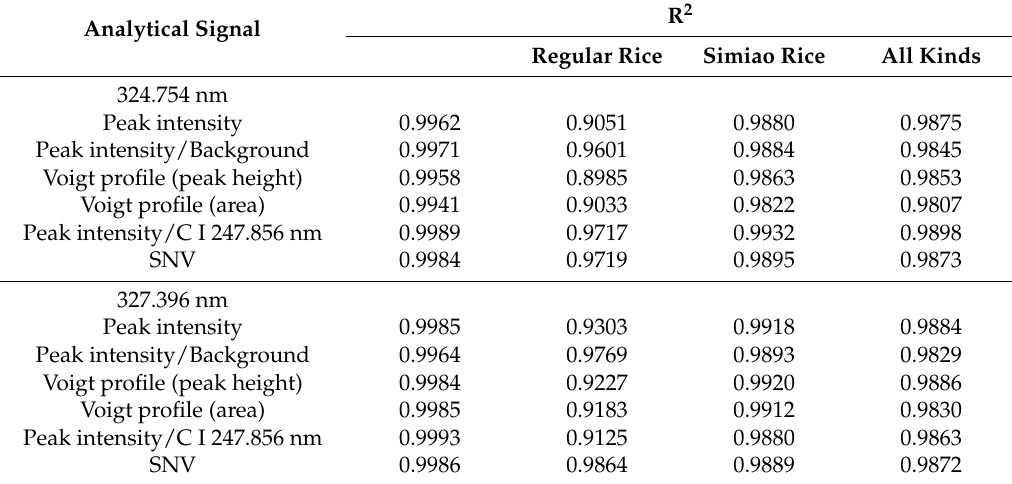
Table 2. The results for univariate calibration with different pre-processing